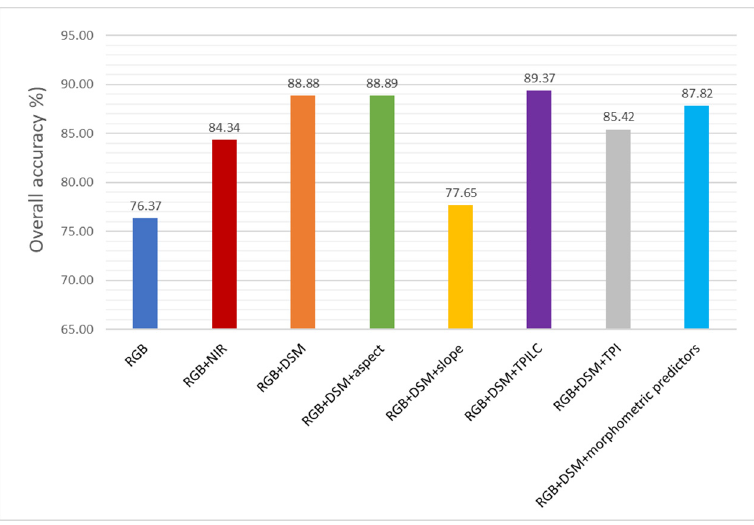
( d ) Figure 9. Morphometric variables derived form the best Pleiades–1 DSM#2–3_1: slope in degrees ( a ); aspect ( b ); topographic position index, (TPI) ( c ); TPI–based landform classification ( d ). 3.3. Pixel–Based Classification 3.3.1. Overall Accuracy at the Landscape Scale At the landscape scale, each band combination was assessed. To test individual con-